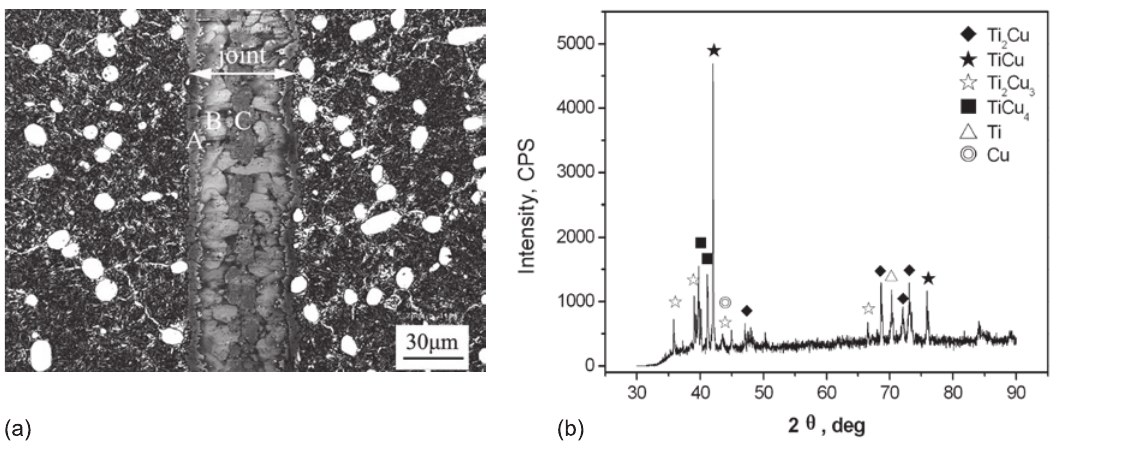
Fig. 2: Joint produced at 900 °C × 1 min. a: joint microstructure, b: XRD pattern taken from the fracture surface of the joint